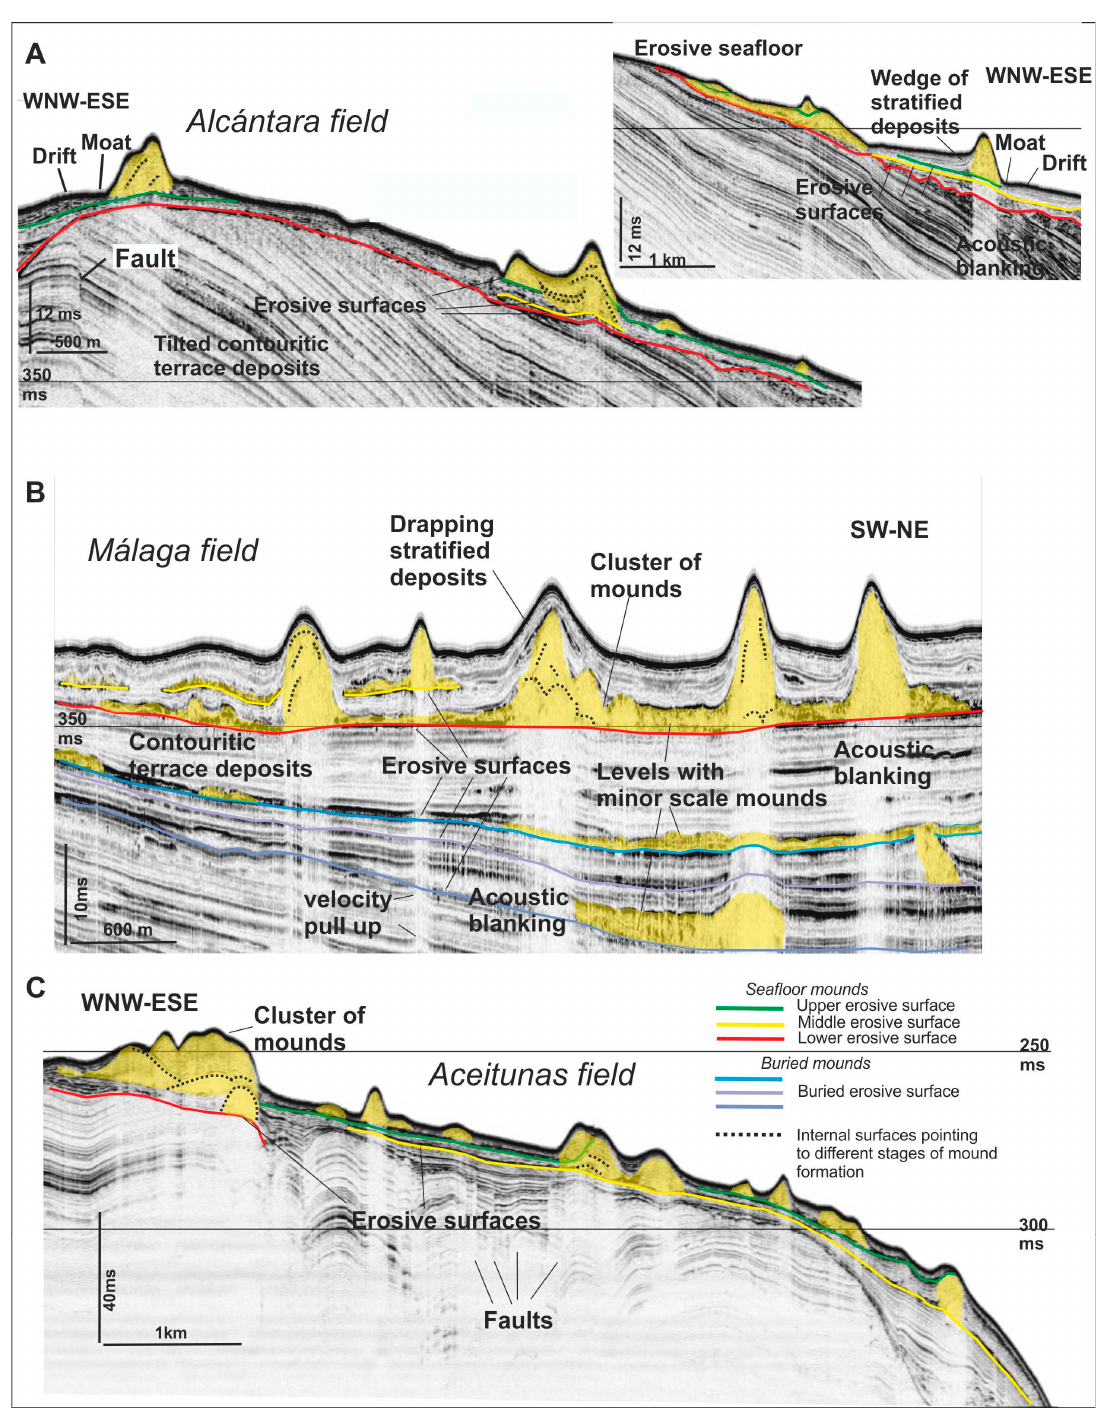
Figure 3. High-resolution sub-bottom parametric profiles showing some carbonate mounds and contourite drift sequences of the ( A ) Alcántara mound field; ( B ) Málaga mound field and ( C ) Aceitunas mound field in the northern Alboran Sea. Location of the profiles is shown in Figure 1B– D.